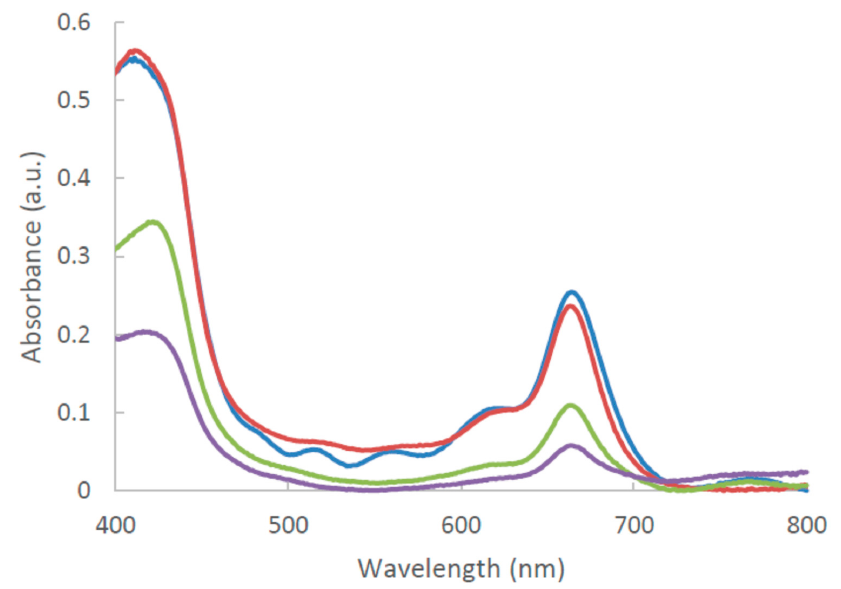
Figure 2. UV-Visible absorption spectra of TiO 2 films impregnated with M2 (0.3 mM in THF) and increasing co-adsorbent concentration (0 mM: blue line; 0.3 mM: red line; 1.5 mM: green line, and 3 mM: purple line in THF).